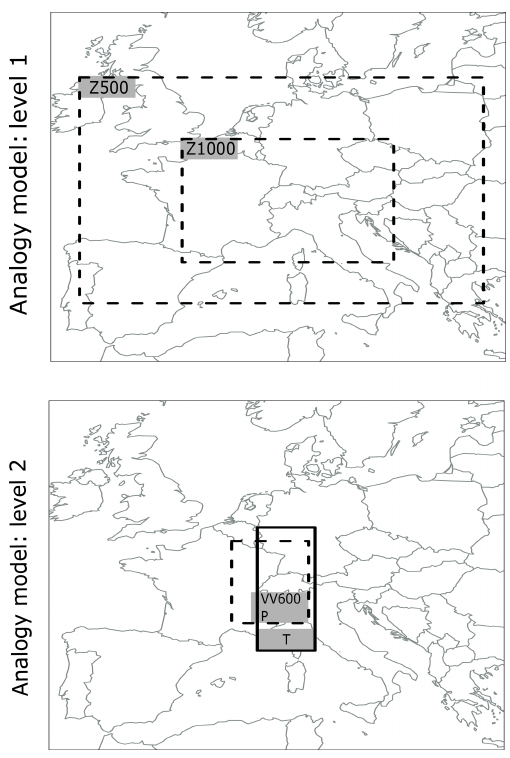
Figure 2. Positions and dimensions of the analogy windows in the analogue model at both analogy levels. Z500: geopotential at 500hPa; Z1000: geopotential at 1000hPa; VV600: vertical veloci- ties at 600hPa; P : precipitation; T :